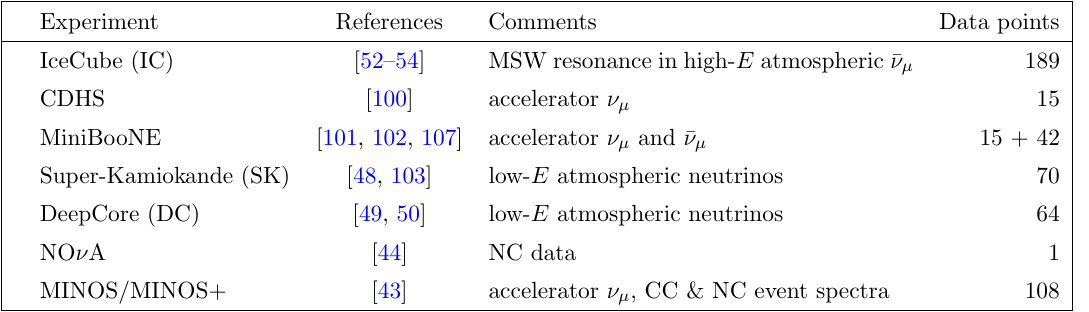
Table 4 . Experimental data sets included in our ( number of data points in this channel is